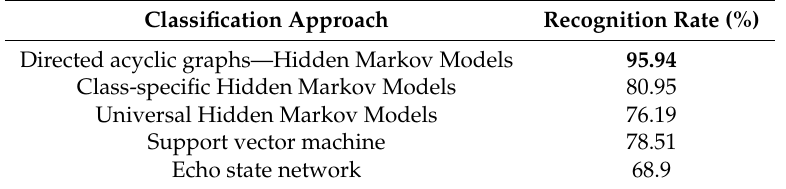
Table 2. The recognition rates achieved by each classification approach. The highest one is